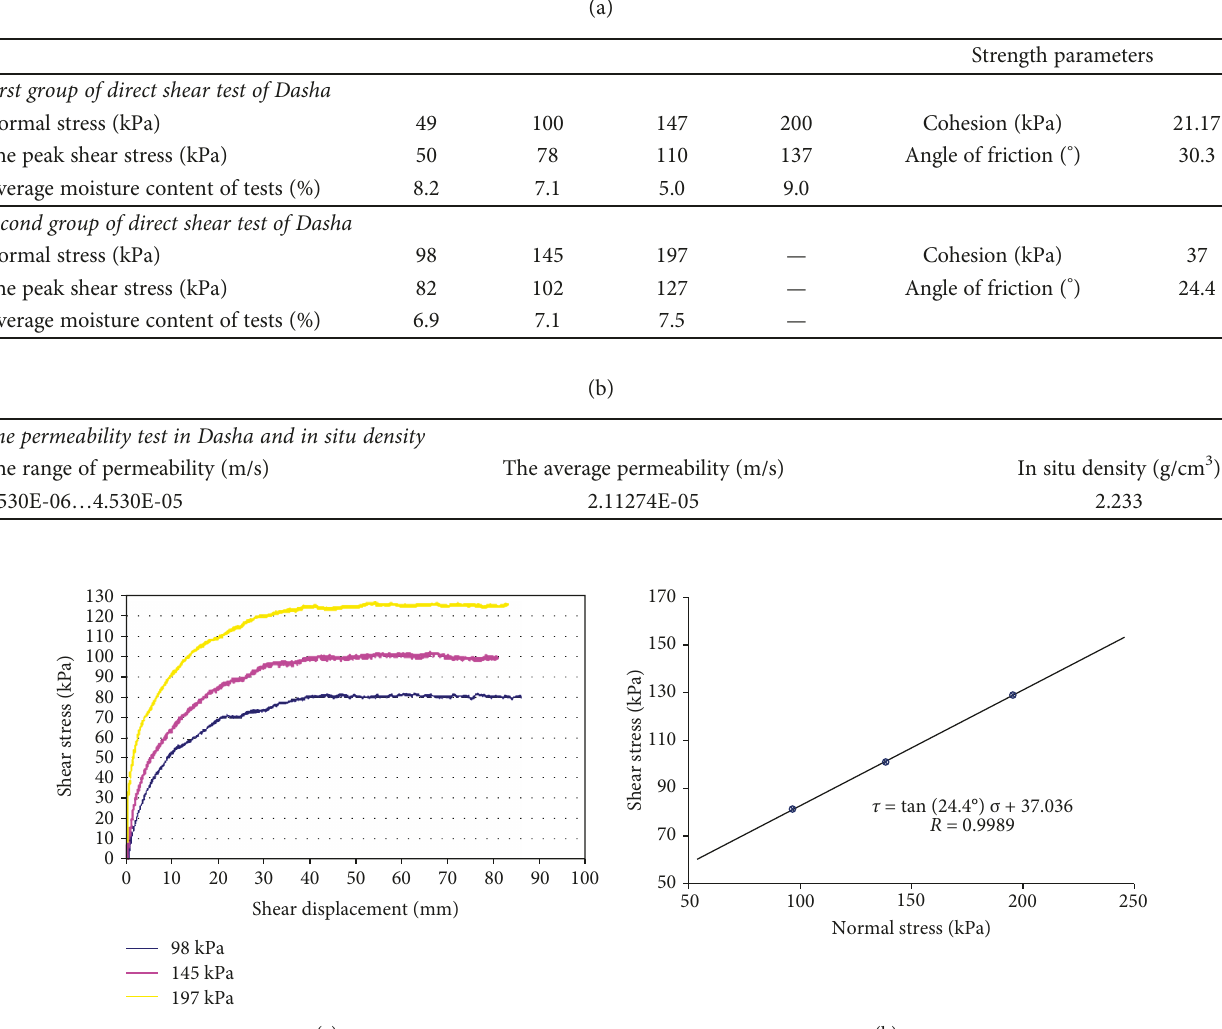
Table 3: The test results of di ff erent parameters on site.